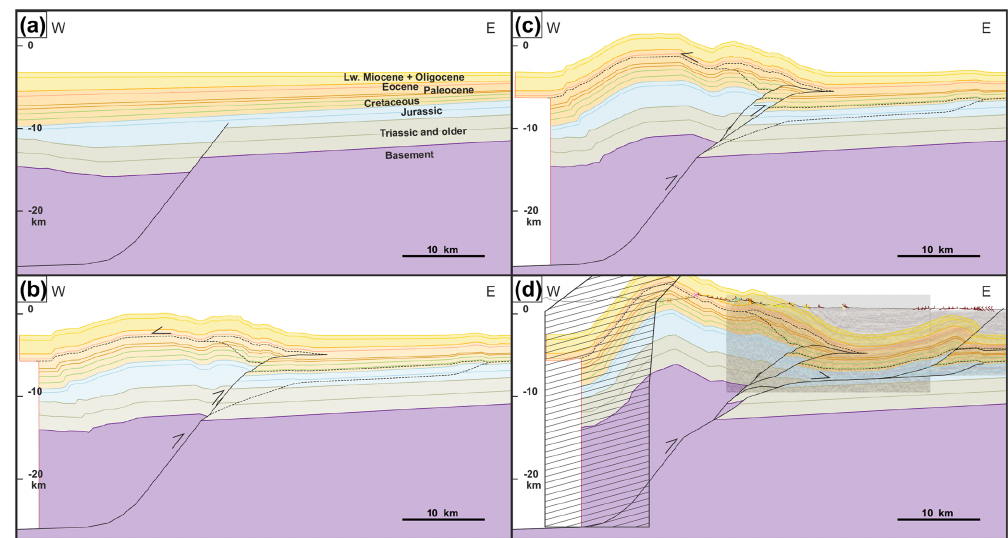
Figure 16. Simplified kinematic evolution of the southern sector. (a) Pre-contractional situation with Jurassic normal fault. Thin stippled lines indicate faults of dominant layer-parallel shortening. (c, b) Incremental deformation of imbrication and passive roof thrusting above the inverting normal fault. (d) Final geometry of the kinematic forward model compared to seismic and surface geology. The geometry in the hatched area in the western part of the section does not fit the surface geology and would require additional deformation by inverting faults and cover sediments not regarded in this